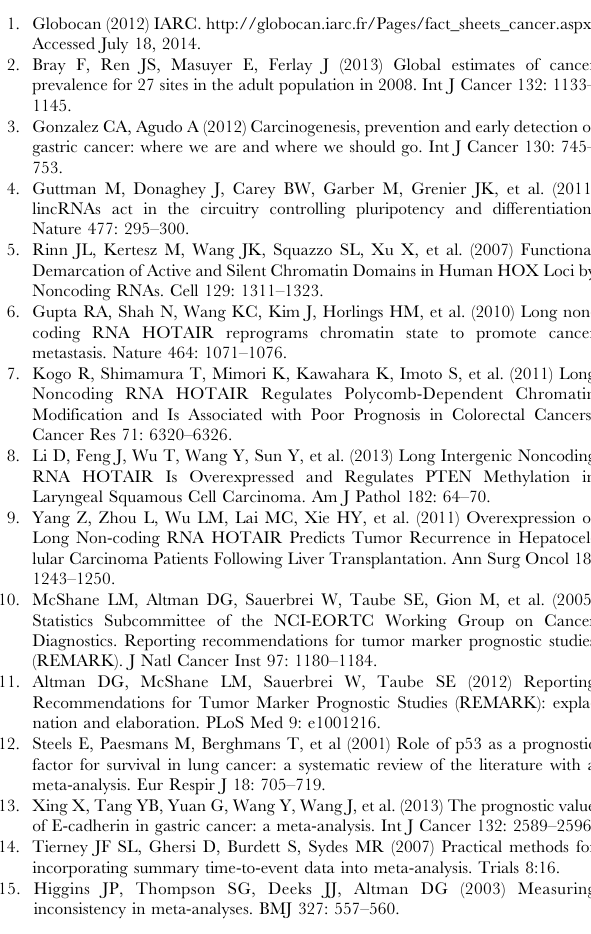
Figure S2 Funnel plot for the analysis of the association between HOTAIR expression and OS/RFS/MFS of cancer. (A)Funnel plot for the analysis of the association between HOTAIR expression and OS of cancer; (B) Funnel plot for the analysis of independent prognostic role of HOTAIR in different types of cancer; (C) Funnel plot for the analysis of the association between HOTAIR expression and RFS of cancer; (D) Funnel plot for the analysis of the association between HOTAIR expression and MFS of